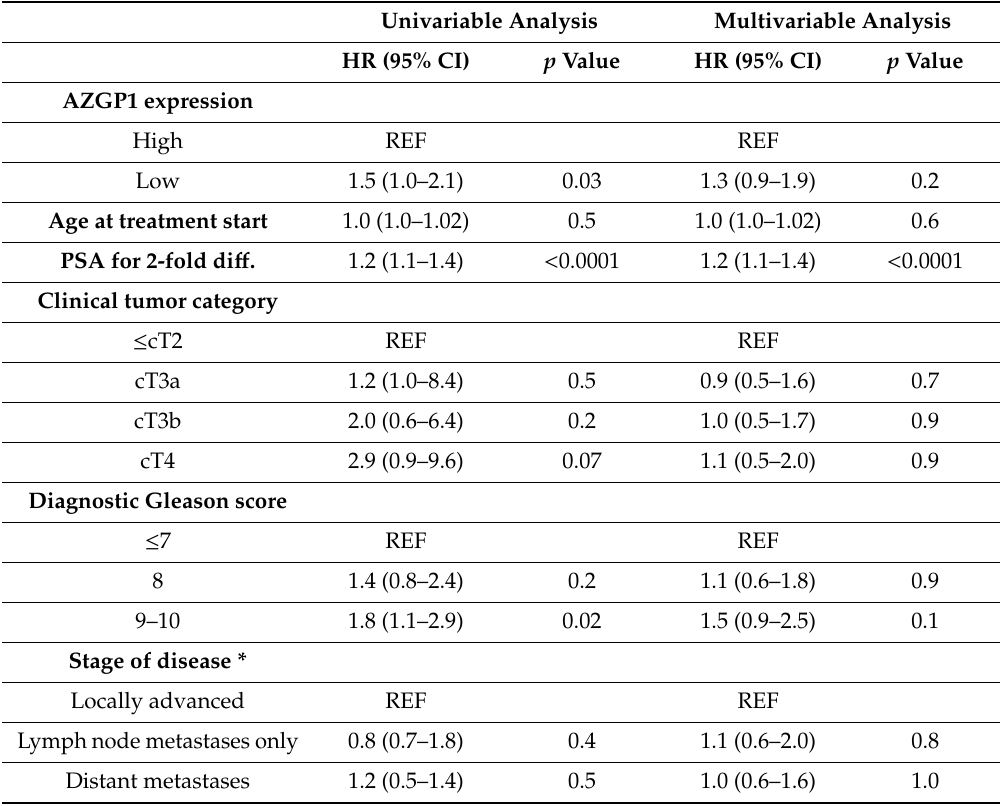
Table 2. Uni- and multivariable cause-specific Cox proportional hazards of the risk of CRPC.